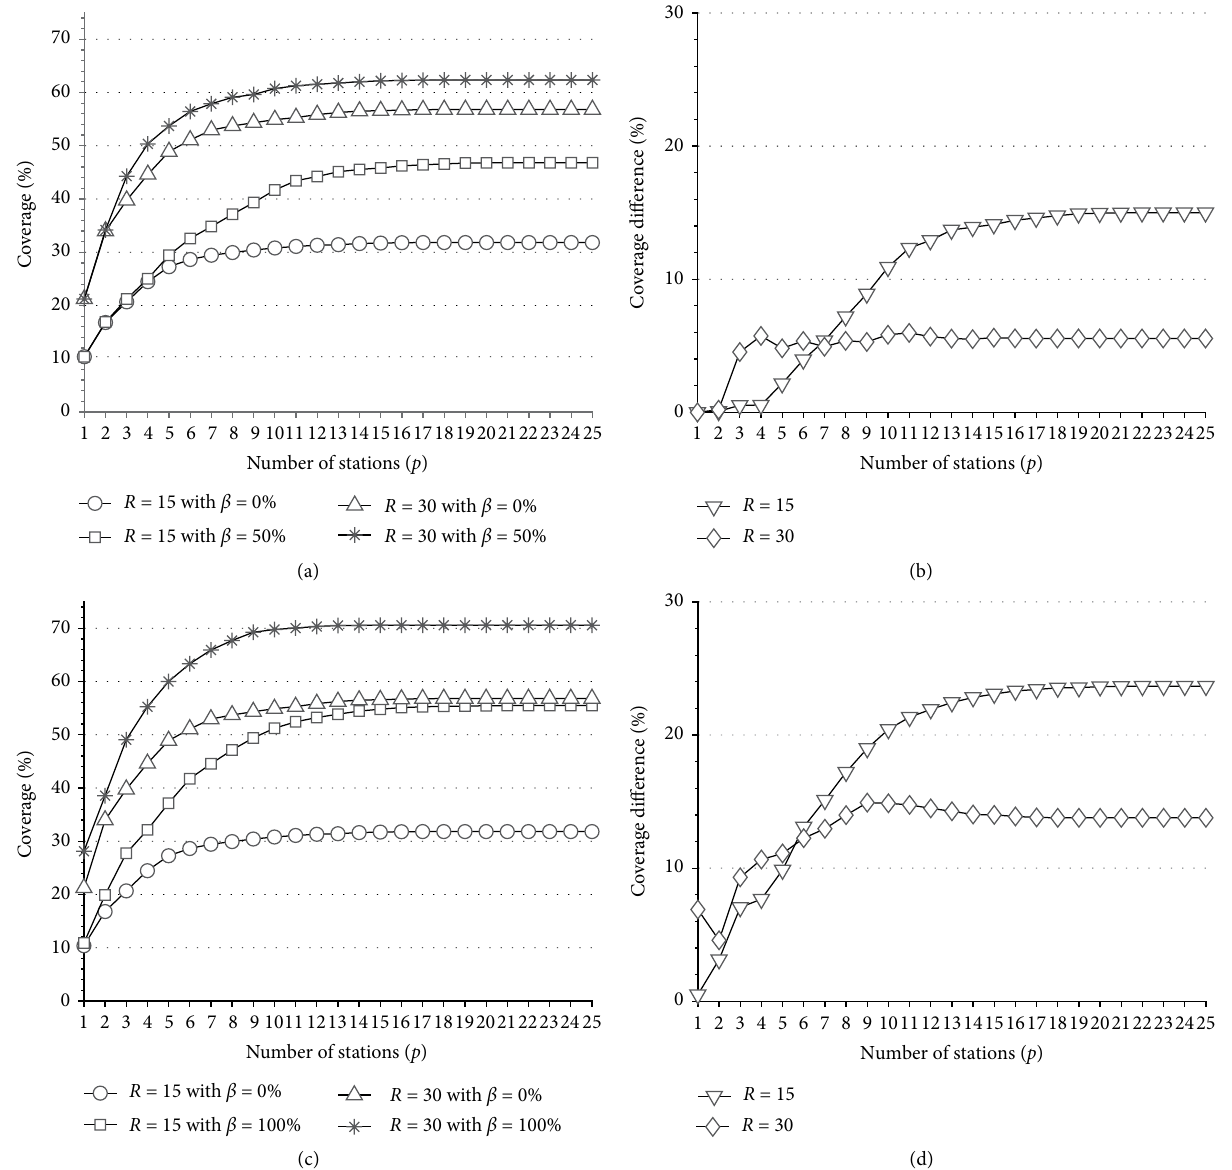
Figure 7: Comparisons of the optimal coverages of no-detour versus detour flows and their coverage differences when 푅 = 15, 30 with % . (b) Coverage differences between no-detour and detour flows for 푅 = 15, 30 (a) Coverages of no-detour versus detour flows with 훽 = 50 % . (c) Coverages of no-detour versus detour flows with % . (d) Coverage differences between no-detour and detour flows and 훽 = 50 훽 = 100 % for 푅 = 15, 30 and 훽 = 100